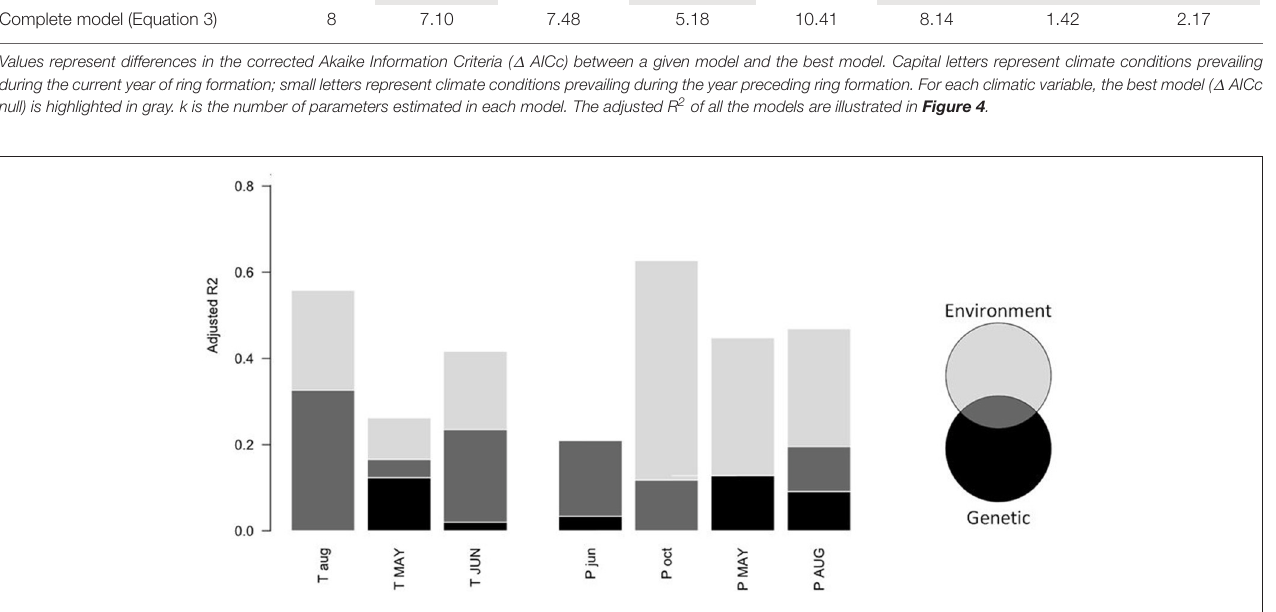
However, our results evidenced a strong confounding